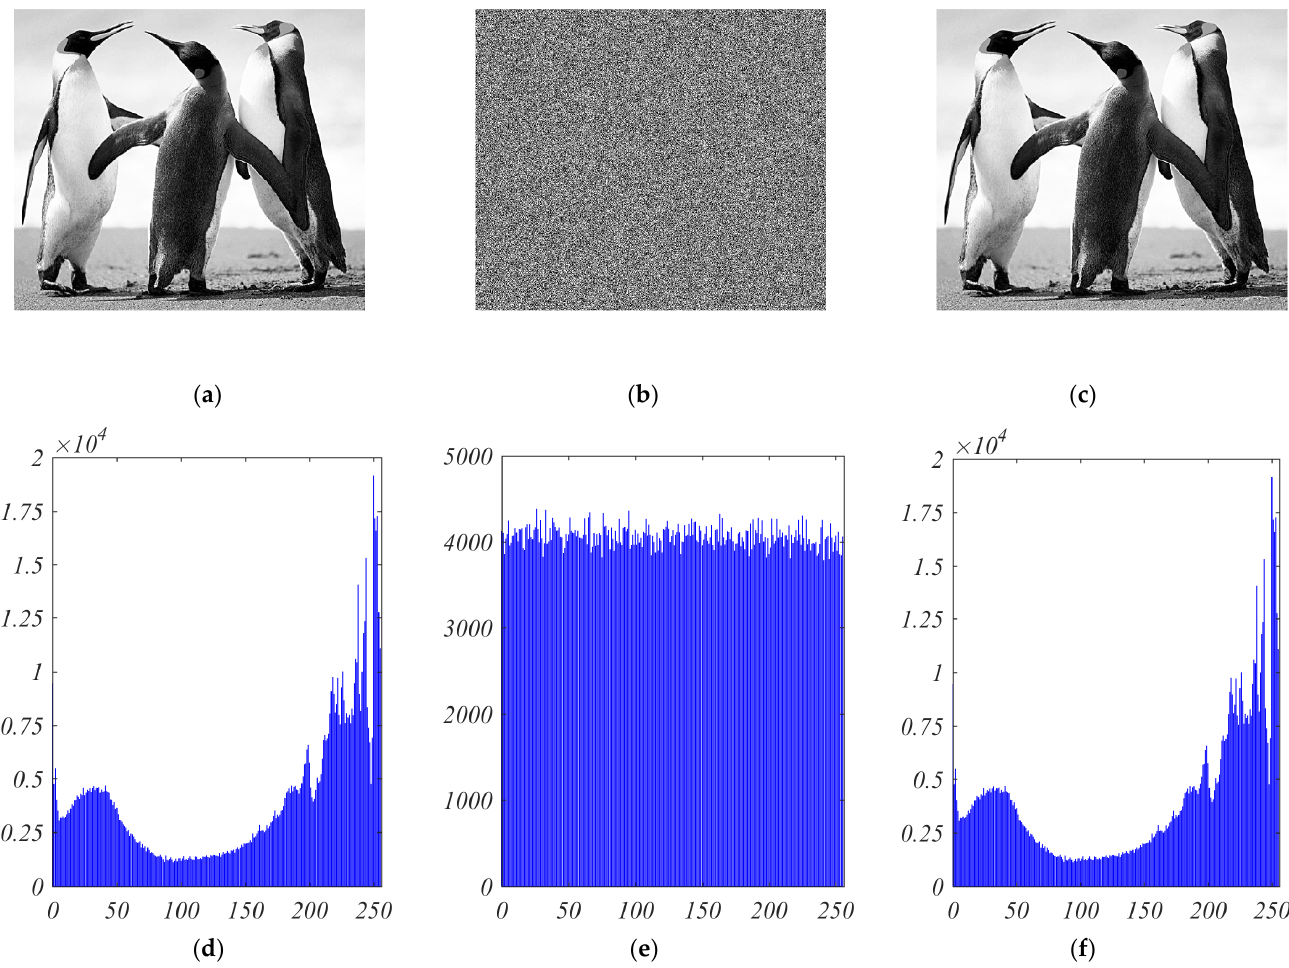
Figure 22. Encryption and decryption of “penguins.jpg” 546 × 636 grayscale image: ( a ) the original image; ( b ) encrypted image; ( c ) the decrypted image; ( d ) histogram corresponding to ( a ); ( e ) histogram corresponding to ( b ); ( f ) histogram corresponding to ( c